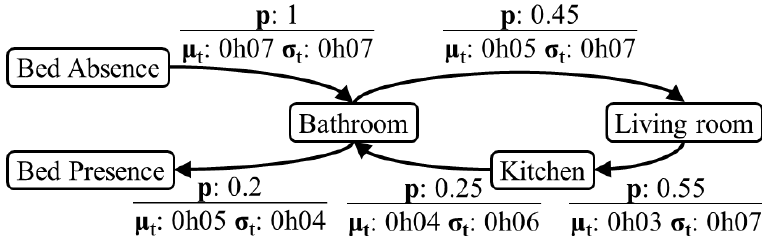
Figure 6. Transition probabilities ( p ) of events for a confidence threshold of 0.2. Mean ( µ and standard deviation ( σ ) of the transition time (normally t